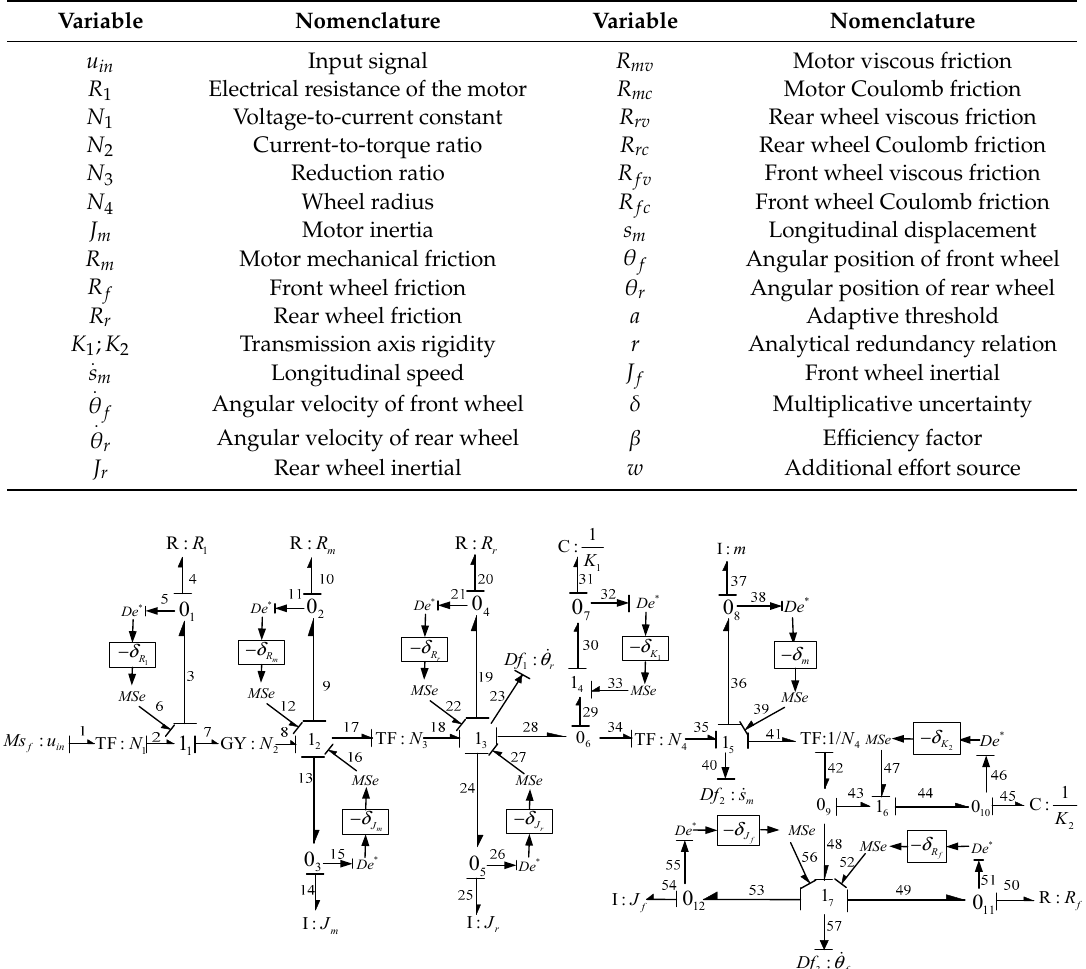
Figure 2. Uncertain bond graph (UBG) of the electric scooter.